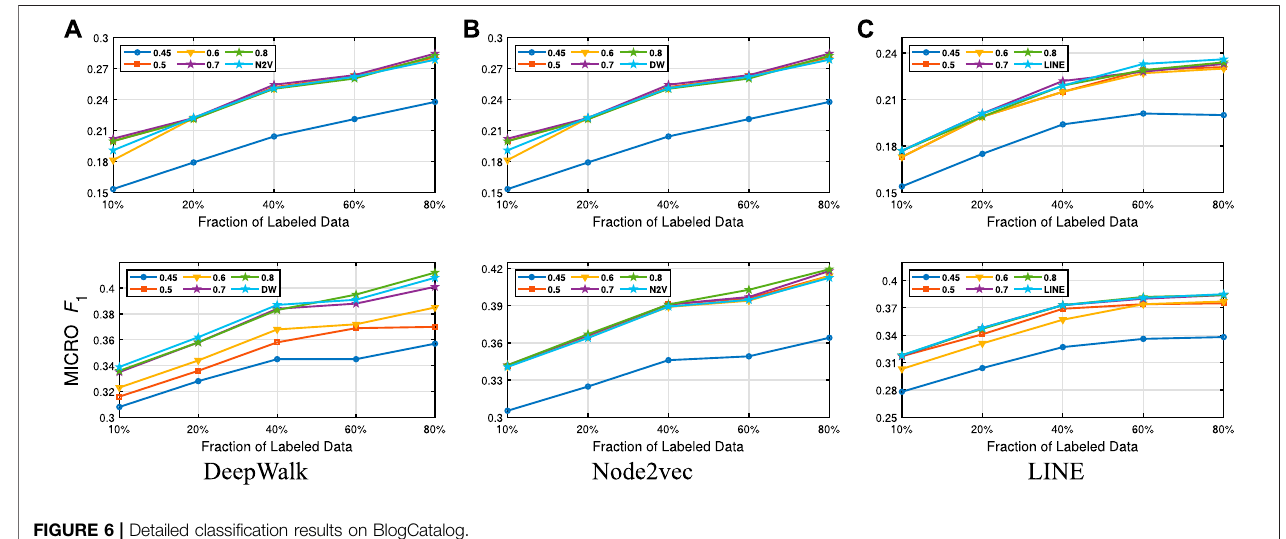
FIGURE 6 | Detailed classi fi cation results on BlogCatalog.